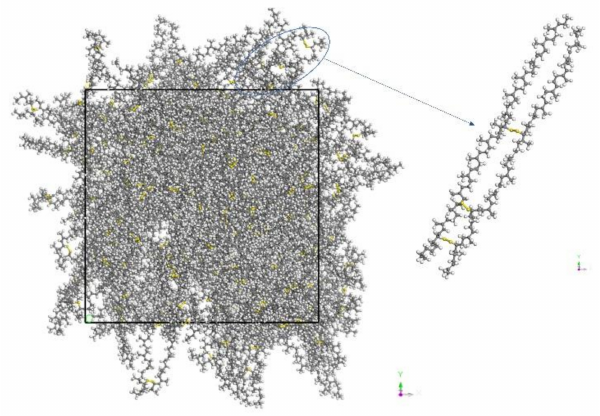
Figure 11. SEUG discrete system consisting of 100 SEUG monomers cross-linked with C-S-S-C bonds ( DC =